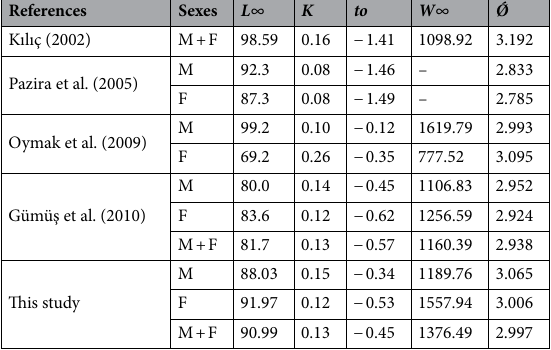
Table 3. VBGE parameters of different M. mastacembelus